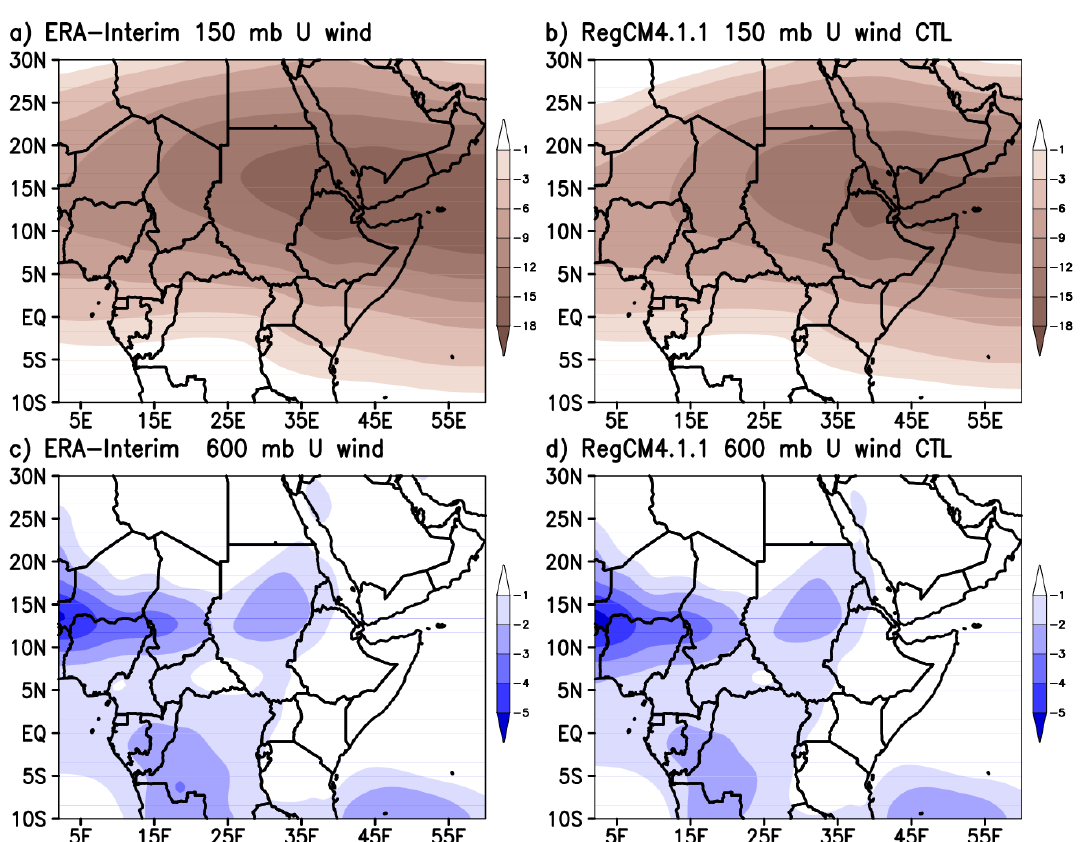
Figure 6. Averaged zonal wind (inms − 1 ) for JJAS 1982–2009: (a) ERA Interim at 150mb, (b) Reg-TB at 150mb, (c) ERA Interim at 600mb, and (d) Reg-TB at 600mb. Model data are ensemble